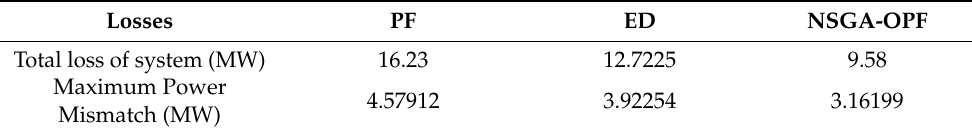
Table 4. Comparison of power loss and mismatch among different